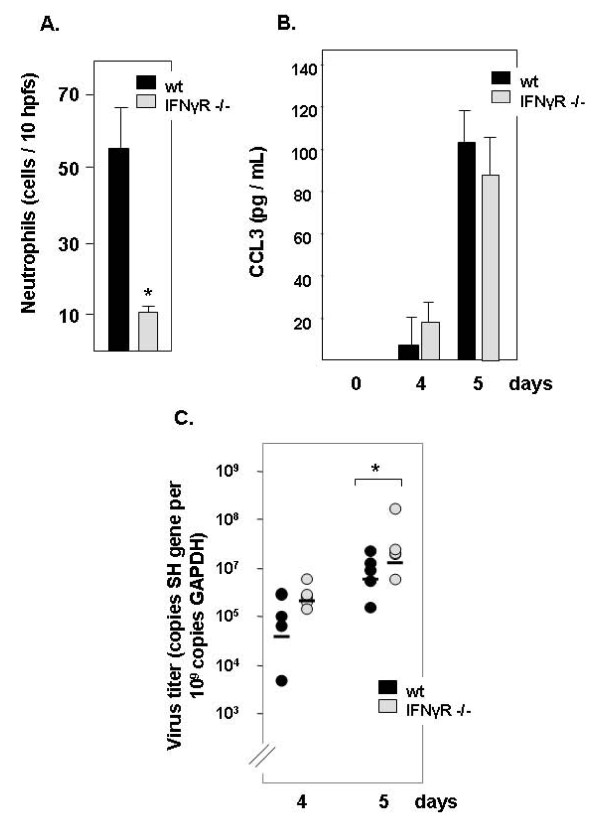
Neutrophil recruitment in response to PVM infection is diminished in IFN-γR gene-deleted mice. (A) Neutrophils detected in BAL fluid 5 days after inoculation; hpf, high power field; *p < 0.001;(B) Detection of CCL3 in BAL fluid; *p < 0.001 (C) Virus copy number detected in lung tissue determined by quantitative RT-PCR.